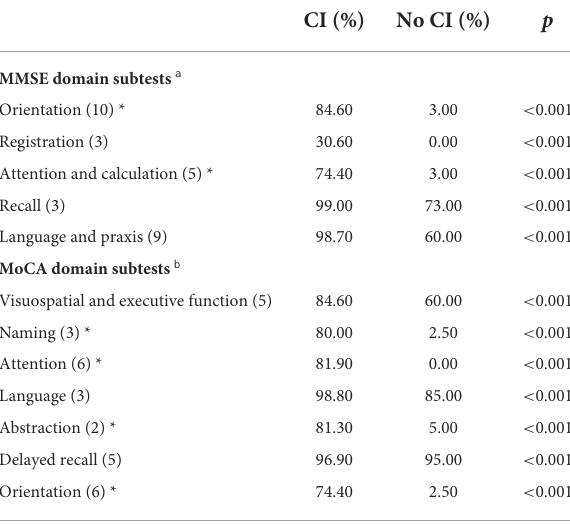
TABLE 5 Comparisons of the average MoCA and MMSE domain subtest